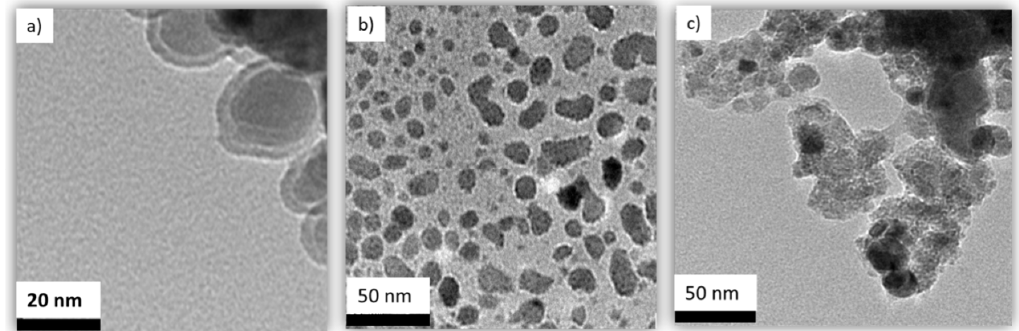
Figure 4. The transmission electron microscopy (TEM) micrographs of ( a ) Ag / Fe, ( b ) APTES–Ag / Fe, and ( c ) PEI–Ag / Fe.